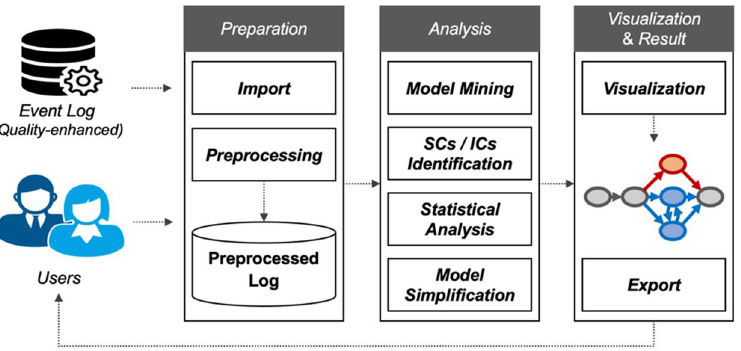
Figure 5. The architecture of the implemented tool.